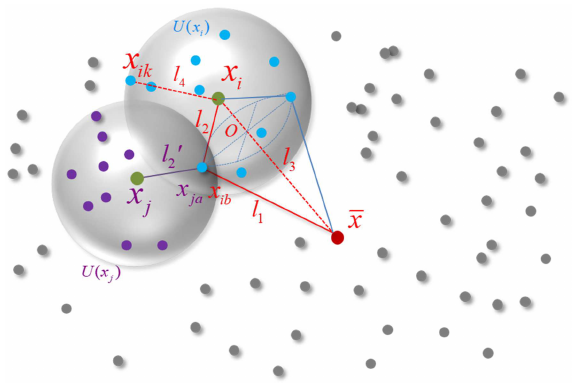
Figure 4. TIF analysis. l 3 , l 4 are necessary for improving the uniqueness of